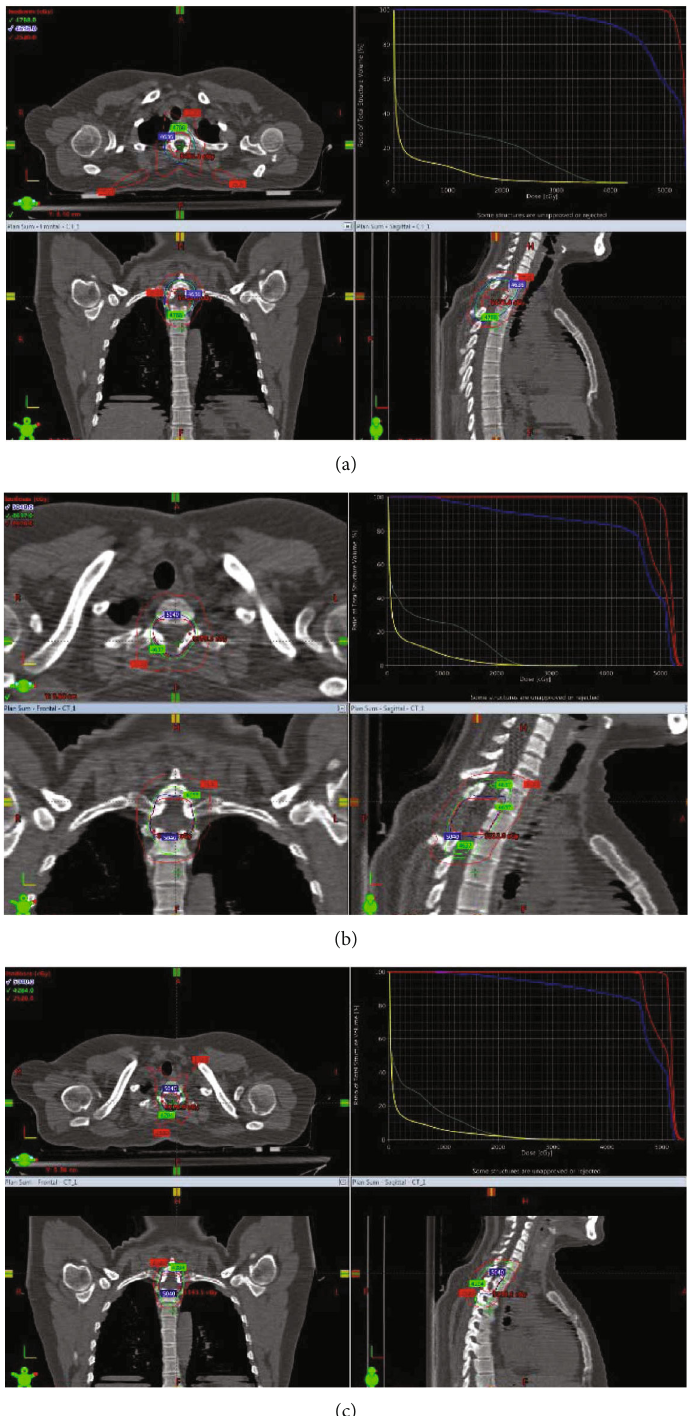
Figure 3: Plan summations and dose volume histogram (DVH) of 3DCRT, IMRT, and ARC. (a) Plan summations on axial (upper left), frontal (lower left), and sagittal (lower right) views and DVH graph (upper right) of conformal three-dimensional plan. Outer red line of plan summations represents 50% (25.2 Gy) isodose line, green line represents 42.84 Gy, and blue line represents 50.4Gy. Red dots represent maximum point doses on each view. (b) Plan summations on axial (upper left), frontal (lower left), and sagittal (lower right) views and DVH graph (upper right) of intensity-modulated radiation therapy plan. Outer red line of plan summations represents 50% (25.2 Gy) isodose line, green line represents 42.84Gy, and blue line represents 50.4Gy. Red dots represent maximum point doses on each view. (c) Plan summations on axial (upper left), frontal (lower left), and sagittal (lower right) views and DVH graph (upper right) of volumetric modulated arc therapy plan. Outer red line of plan summations represents 50% (25.2 Gy) isodose line, green line represents 42.84Gy, and blue line represents 50.4Gy. Red dots represent maximum point doses on each